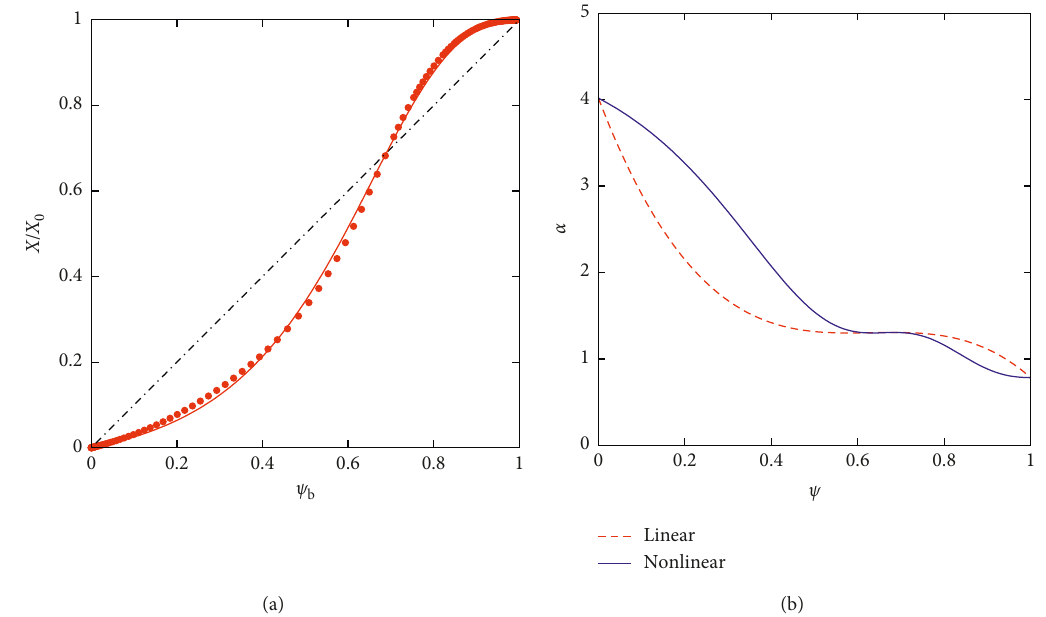
Figure 5: (a) X / X 0 vs. ψ P obtained from the numerical integration of the 1-d moving boundary model with α ( ψ ) (cid:31) (equation (28)) with κ 1 Continuous lines represent the best fit curves S ψ P , Bi m ) ( α ψ obtained with the linear approximation X / X 0 ψ P (equation (13)) and with the nonlinear approximation (equations (28) and (29)). ( ) (cid:31) G 4th X / X X / X For both figures, G 0 ) (cid:31) 0 ) (equation (16)). ( (